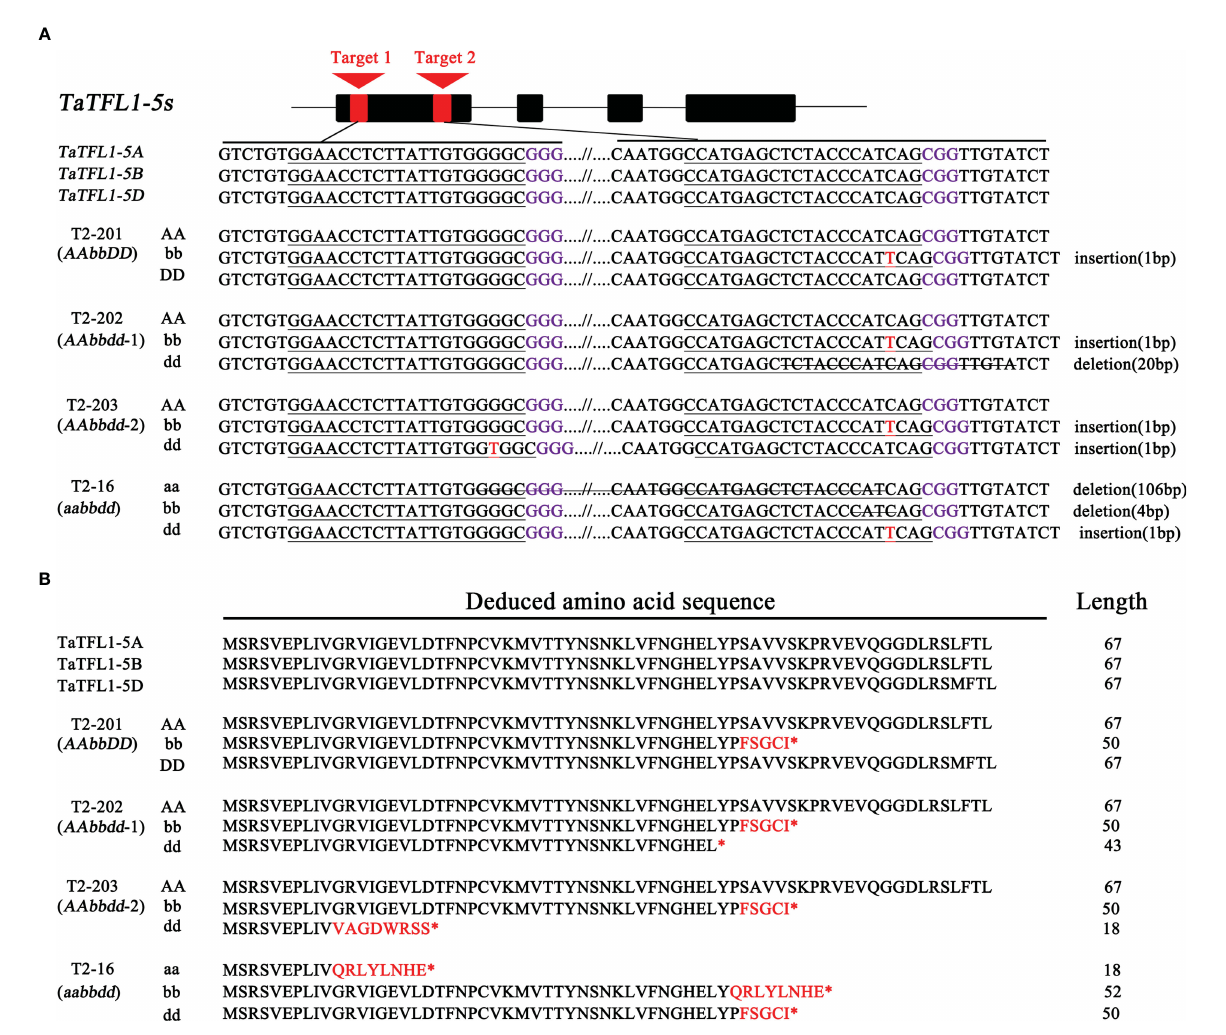
FIGURE 3 CRISPR/Cas9-mediated targeted mutagenesis of TaTFL1-5s gene in wheat. (A) Gene structure of TaTFL1-5s and genotypes of different mutant lines obtained by CRISPR/Cas9 strategy. The PAM motifs are highlighted in purple, and the target sequences are underlined. Insertions are highlighted in red, and the deletions are indicated with strikethrough. Line T2-201 contained a homozygous mutation around target 2 in B genome (an insertion of 1 bp). Line T2-202 had homozygous mutations around target 2 in B genome (an insertion of 1 bp) and in D genome (a deletion of 20 bp). Line T2- 203 had homozygous mutations around target 2 in B genome (an insertion of 1 bp) and around target 1 in D genome (an insertion of 1 bp). In Line T2-16, the homozygous mutations are around target 1 and 2 in A genome (a deletion of 106 bp), around target 2 in B genome (a deletion of 4 bp) and around target 2 in D genome (an insertion of 1 bp). (B) The mutant amino acid sequence in different homozygous mutant lines compared to wild type (WT) Fielder. Substitutions of amino acid residues are shown by red-colored text; “ * ” indicates that translation is